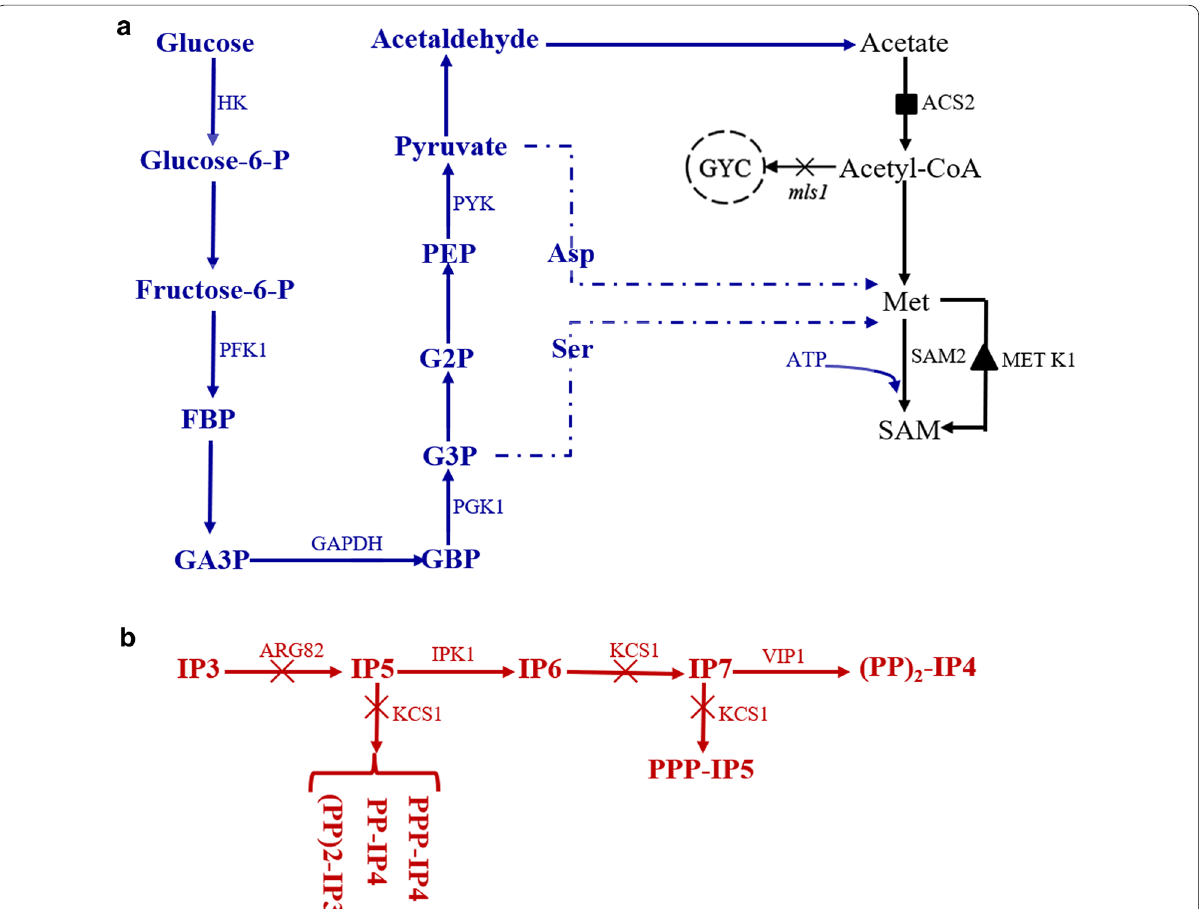
Fig. 1 Schematic representation of increasing glycolysis by deletions of kcs1 and arg82 improved SAM production in Saccharomyces cerevisiae . a The glycolytic intermediates are linked to SAM metabolism; b Pathway for the synthesis of inositol polyphosphates. The color of blue represents the glycolysis pathway enhanced by deletions of kcs1 and arg82 ; The color of red represents the IPs metabolism. The black triangle represents the introduction of heterologous gene; The black rectangle represents gene over-expression; The red cross represents gene